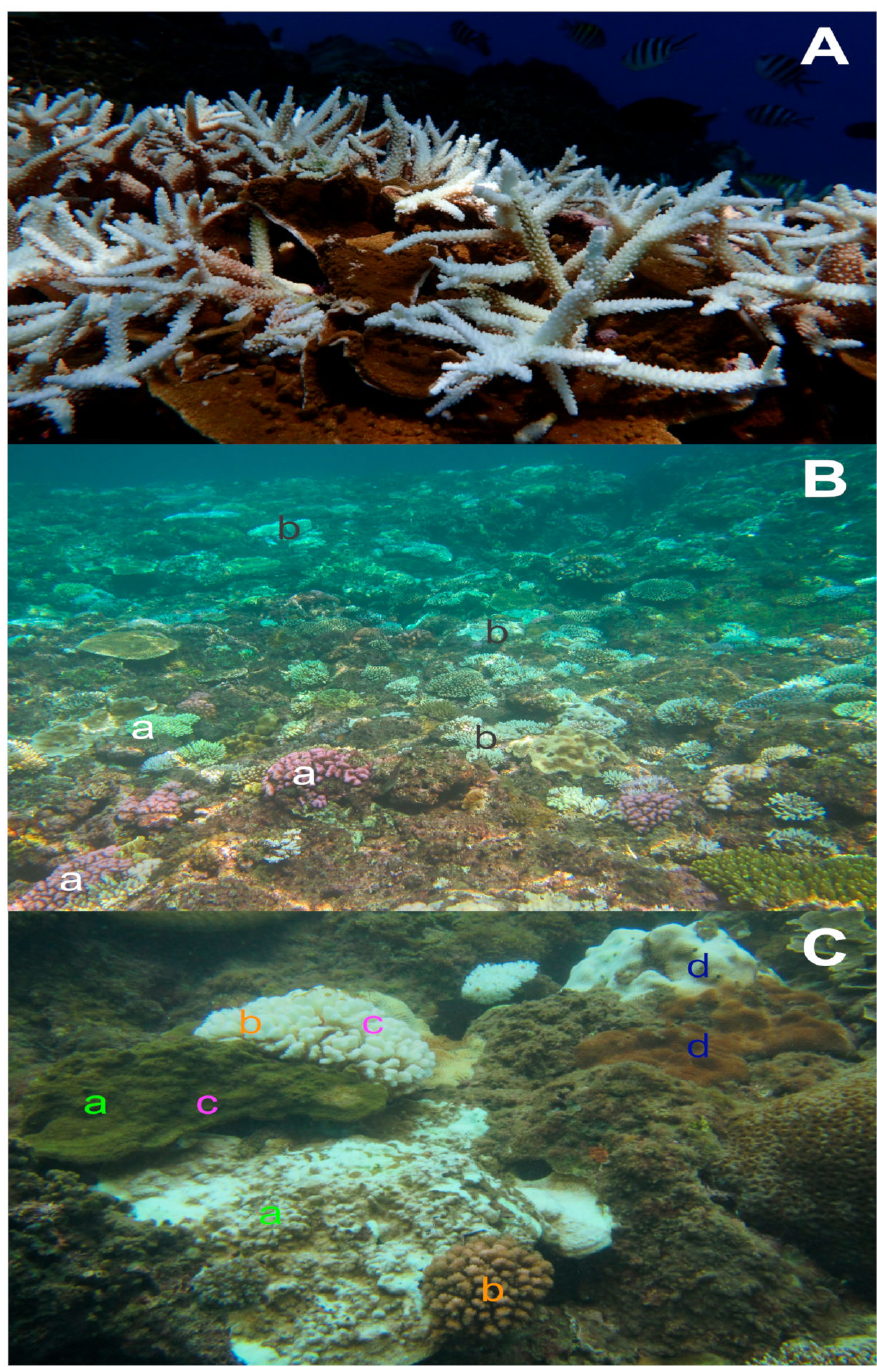
Figure 1. ( A ) Onset of a bleaching process in a colony of Acropora spp., in Kenting, Taiwan 2015 (Photo: J. Wei); ( B ) Bleaching event showing colonies with fluorescent pigments as a protective mechanism ( a ) and already bleached colonies ( b ), in Okinawa, Japan 2016 (Photo: S.-Y. Yang); ( C ) Intra-specific: between Montipora spp. colonies ( a ) and between Isopora palifera colonies ( b ), inter-specific: between Montipora spp. and I. palifera colonies ( c ) and intra-colony: within Leptoria phrygia colony (d) responses to thermal stress in Kenting, Taiwan 2016 (Photo: R.